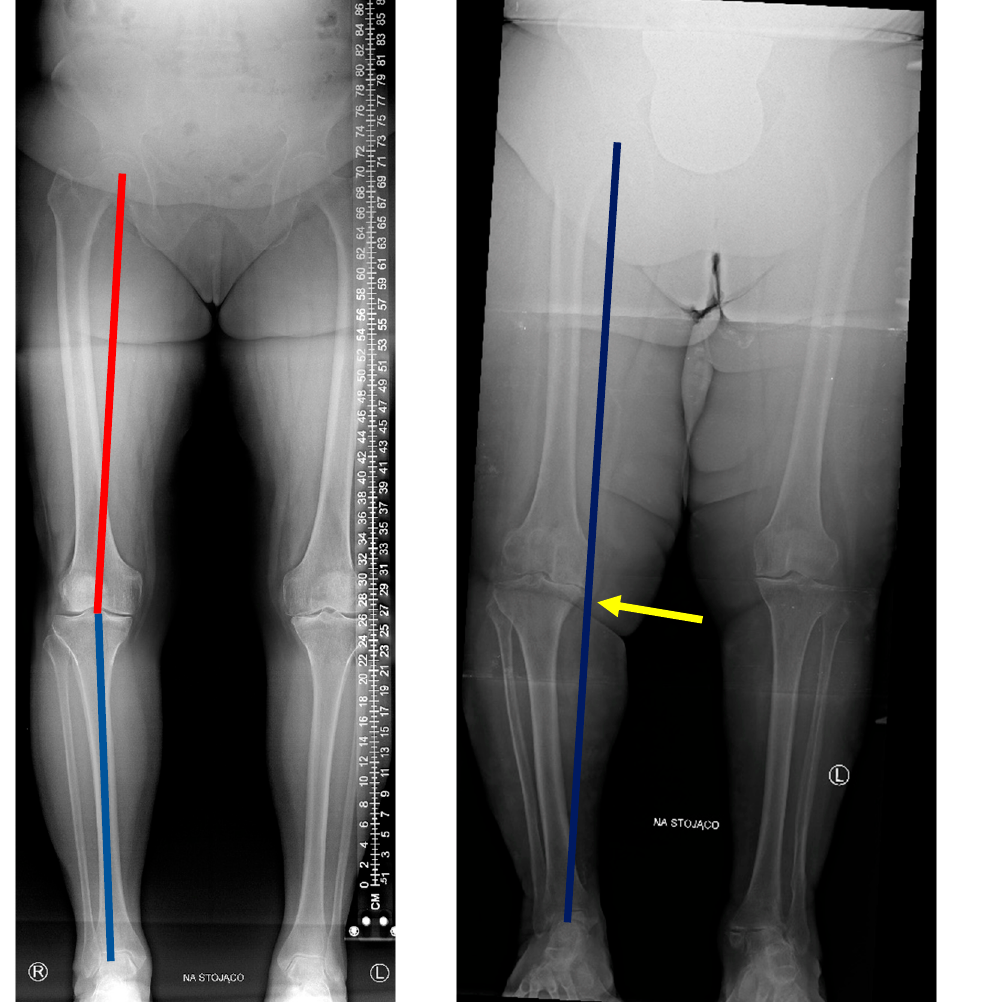
Figure 4. Measurement X-ray of the lower limbs in a patient with a slight varus deformity of the knee joint ( left ) and an advanced deformity ( right ). On the left, HKA angle is presented: red line shows hip–knee line; blue line shows knee–ankle line. On the right: narrowing of the medial compartment (yellow arrow) affecting the mechanical axis of the limb (blue line). The line moved medially indicates varus deformity of the knee joint. Source: proprietary material (description “na stoj ˛aco” [pl] means in the weightbearing